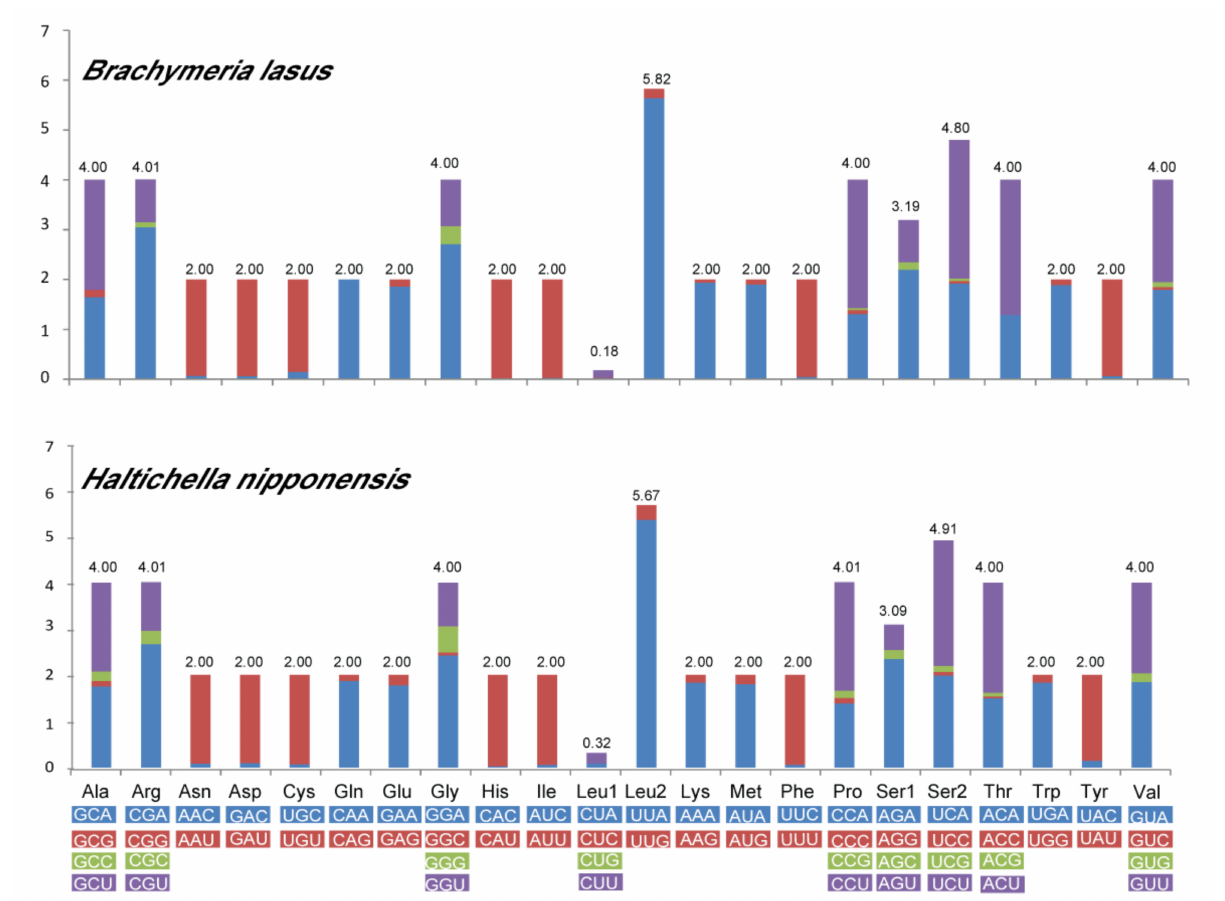
Figure 2. Relative synonymous codon usage (RSCU) in the PCGs of the new sequenced chalcidid mitogenomes. Codon families are indicated below the X